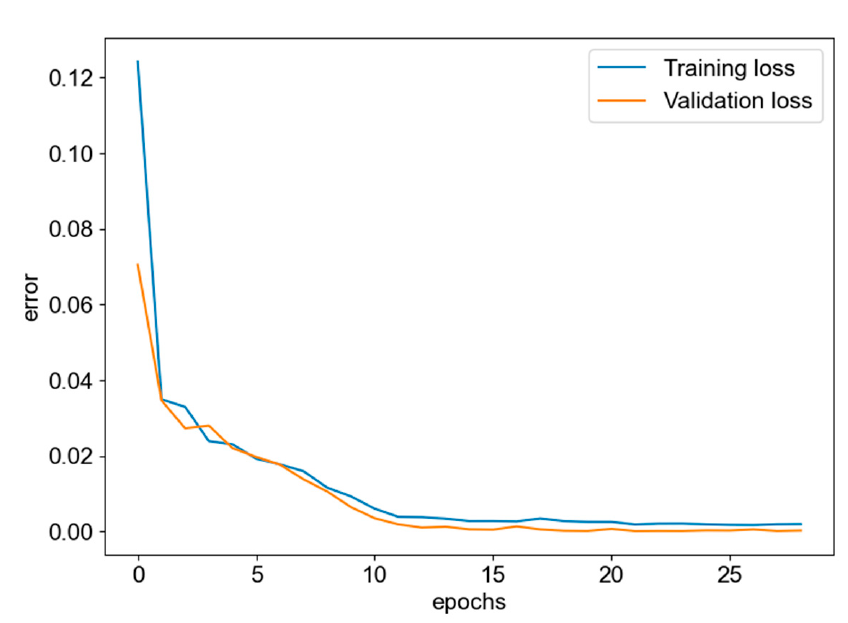
Figure 5. Error curve after adding early stopping strategy.